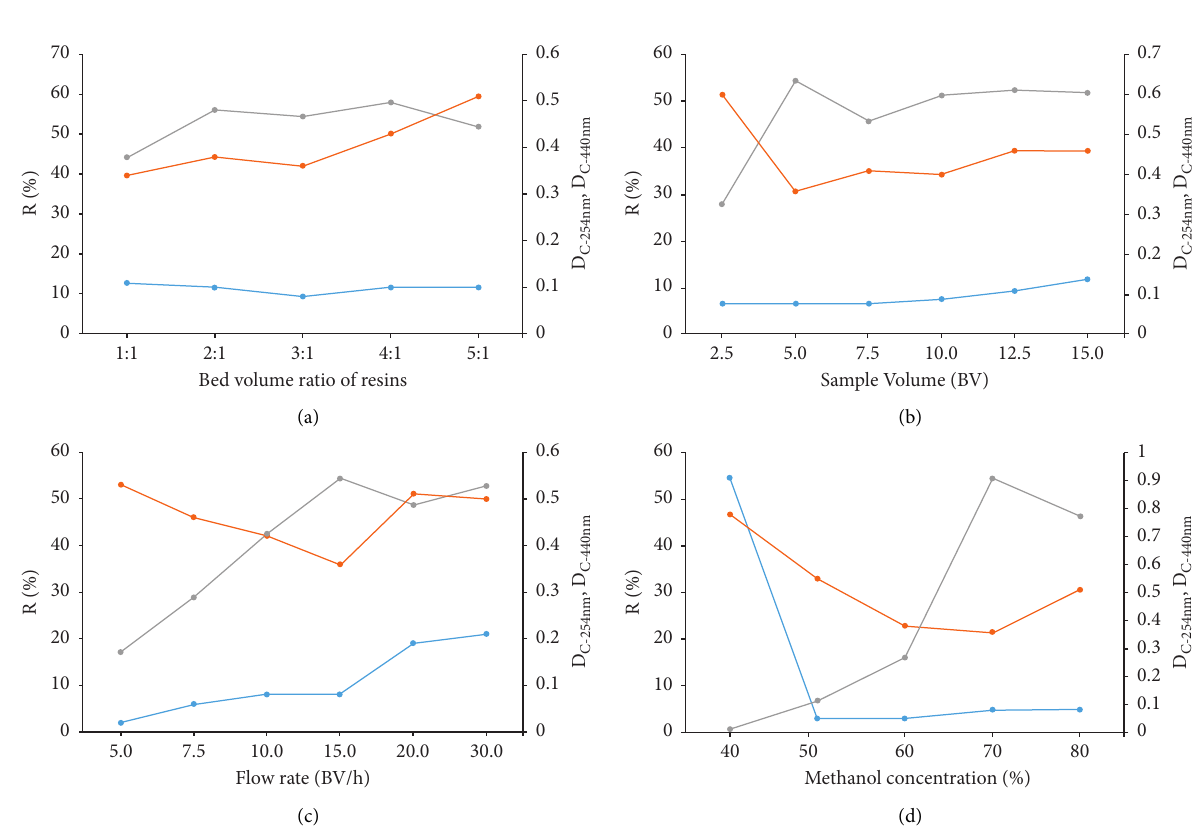
Figure 4: Effect of bed volume ratio of resins (a), sample volume (b), flow rate (c), and methanol concentration (d) on D and R during the process of macroporous resin column in series. represents R , represents D C −